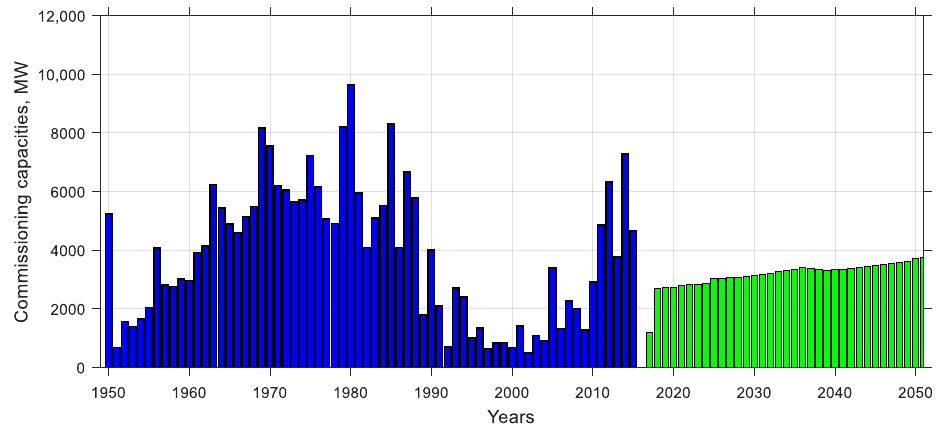
Figure 3. The dynamics of commissioning of capacities of the EPS of Russia in prehistory (1950–2015) and the forecasting period (2016–2050), obtained using model